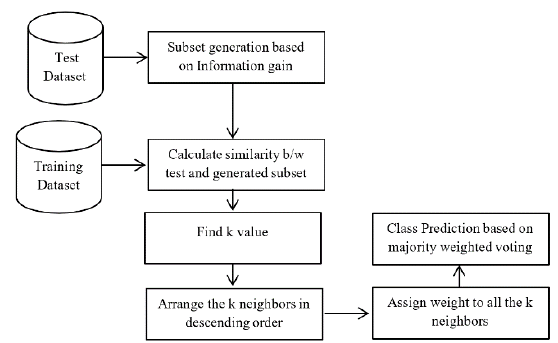
Fig. 2. Proposed Framework for LLAC_WkNN.